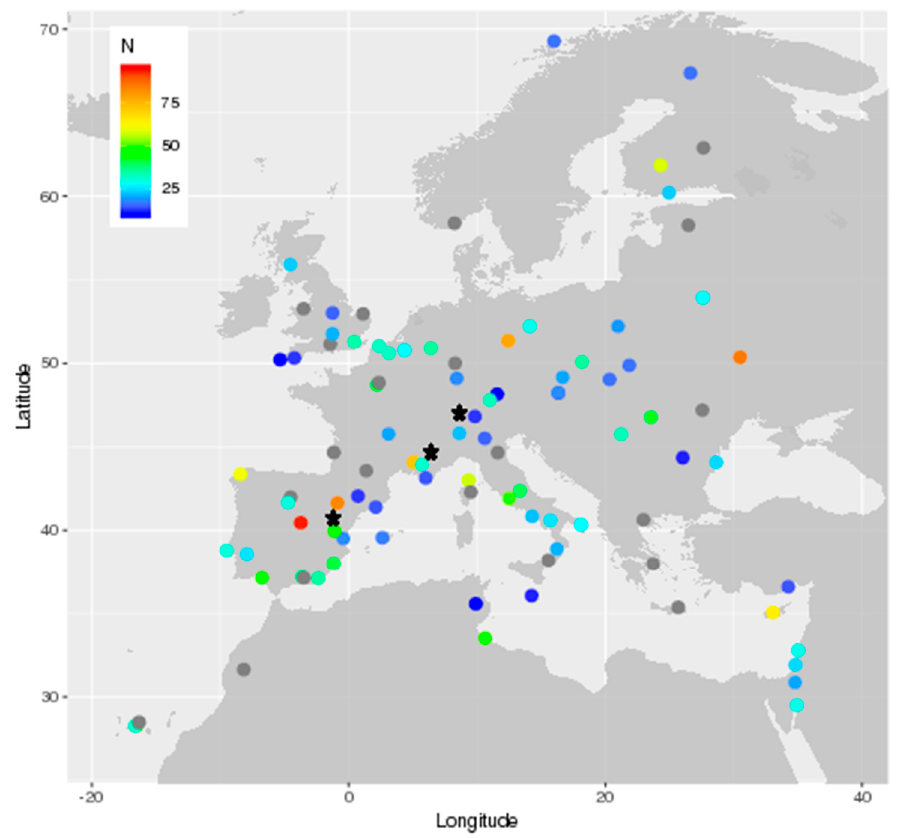
Figure 1. Geographical distribution of the 94 selected AERONET test sites and number of data N available at each site, for the ESA-L2A AOT at 550 nm and integrated water vapour (IWV) validation. The sites with less than 10 data points are represented by the grey dots. The location of the three stations used by Djamai et al. [14] are shown with a black star.